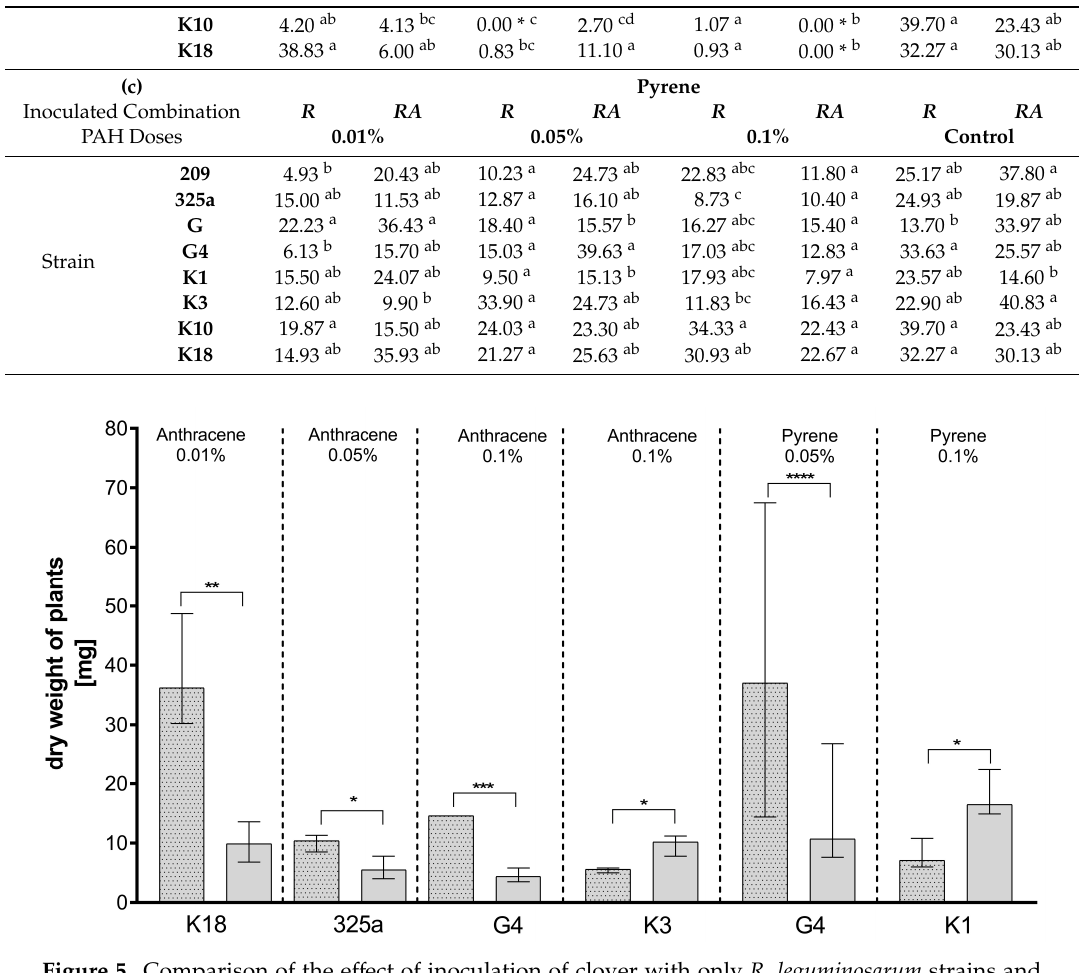
Figure 6. Comparison of the effect of inoculation of clover with only R. leguminosarum strains (R) and with co-inoculation with A. brasilense (RA) on average dry weight values of clover (mg). Control samples were grown without PAH. The results are presented as a boxplot with median and 2.5–97.5